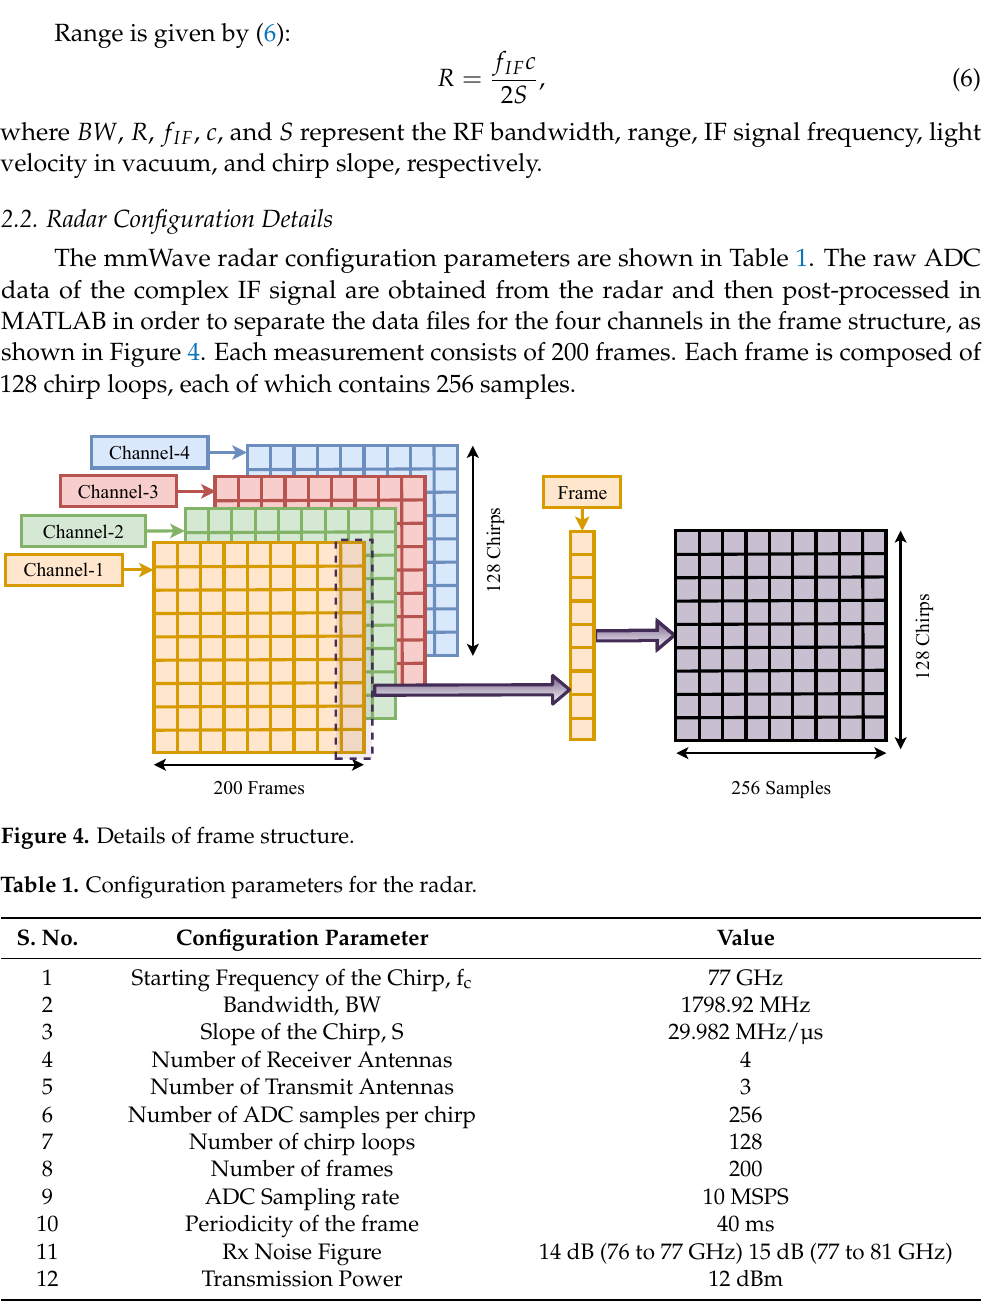
Table 1. Configuration parameters for the Radar